Question: What kind of plot is shown here?
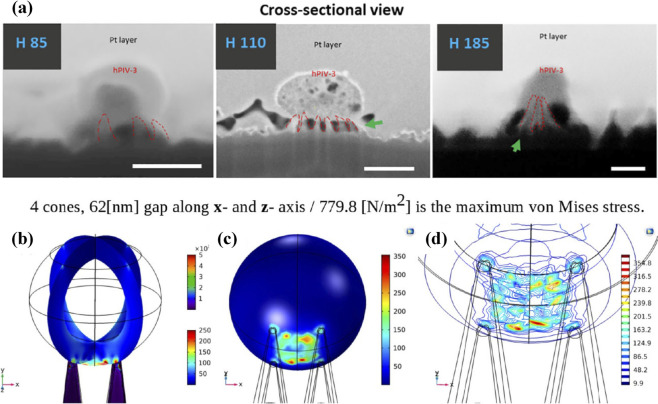
Answer: heatmap